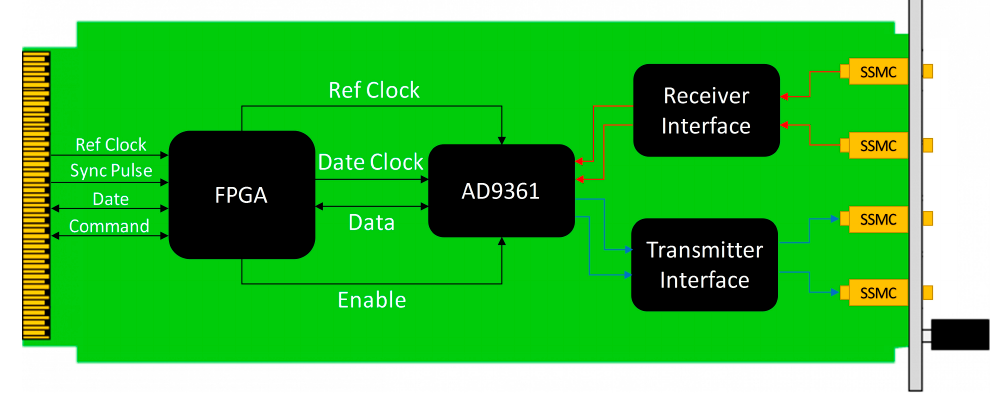
Figure 7. “PU Frontend” Advanced Mezzanine Card (AMC) module architecture (based on existing product used in the testbed).